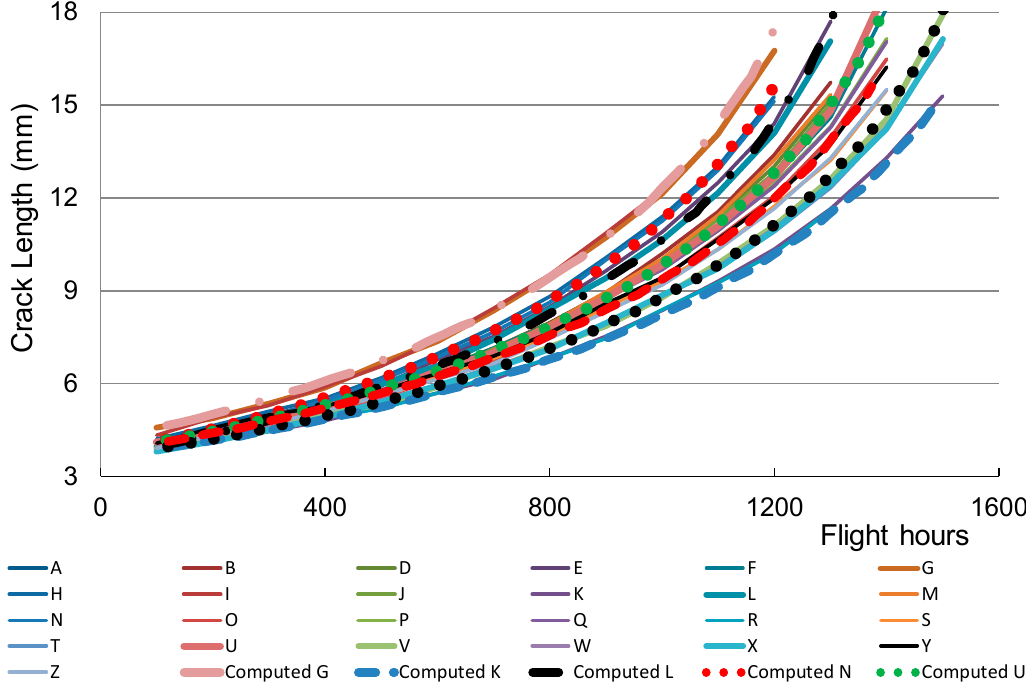
Figure 2. Plot showing the cycle-by-cycle analysis of MT specimens under FALSTAFF load spectrum. Table 1. Values of A and ∆ K thr used in Figure 2 when computing the crack growth curves for the various tests.